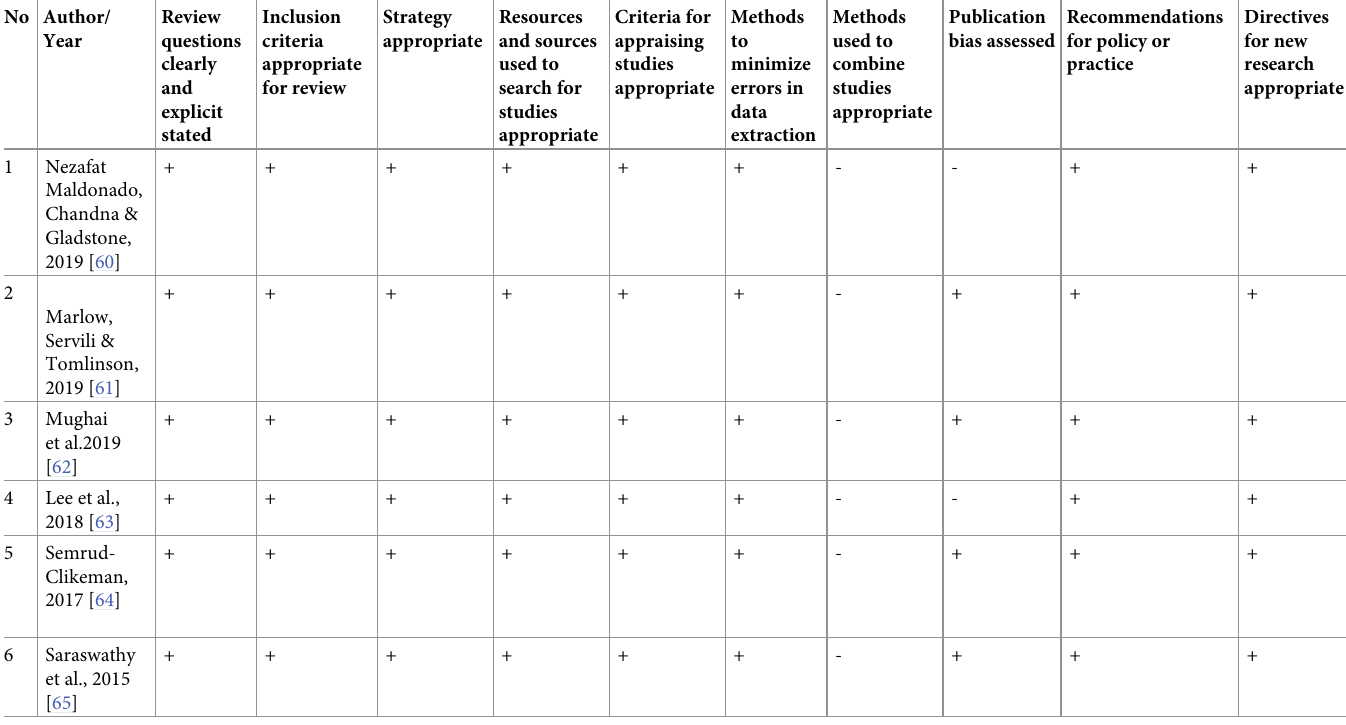
Table 2 the positive (+) sign illustrates, Yes, and the negative (-) sign indicates